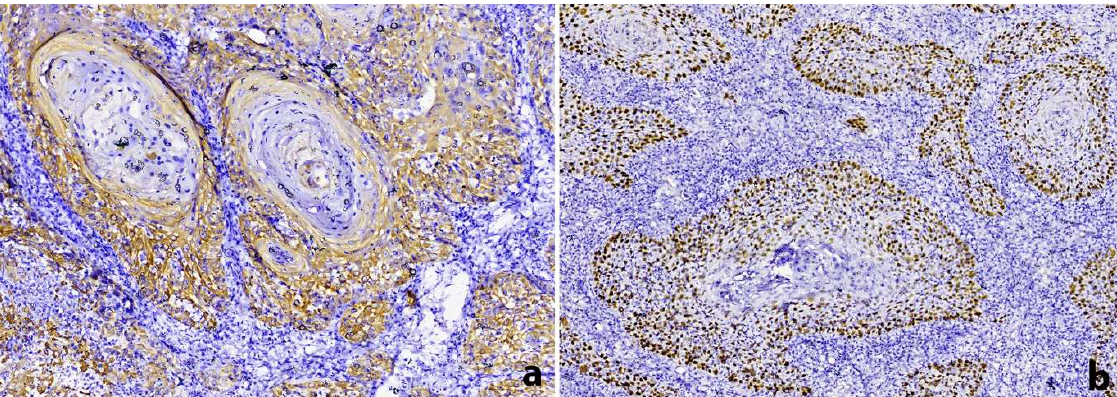
Figure 4. Immunohistochemical analysis showing positivity of the tumor cells for ( a ) cytokeratin AE1/AE3 and ( b ) p63.